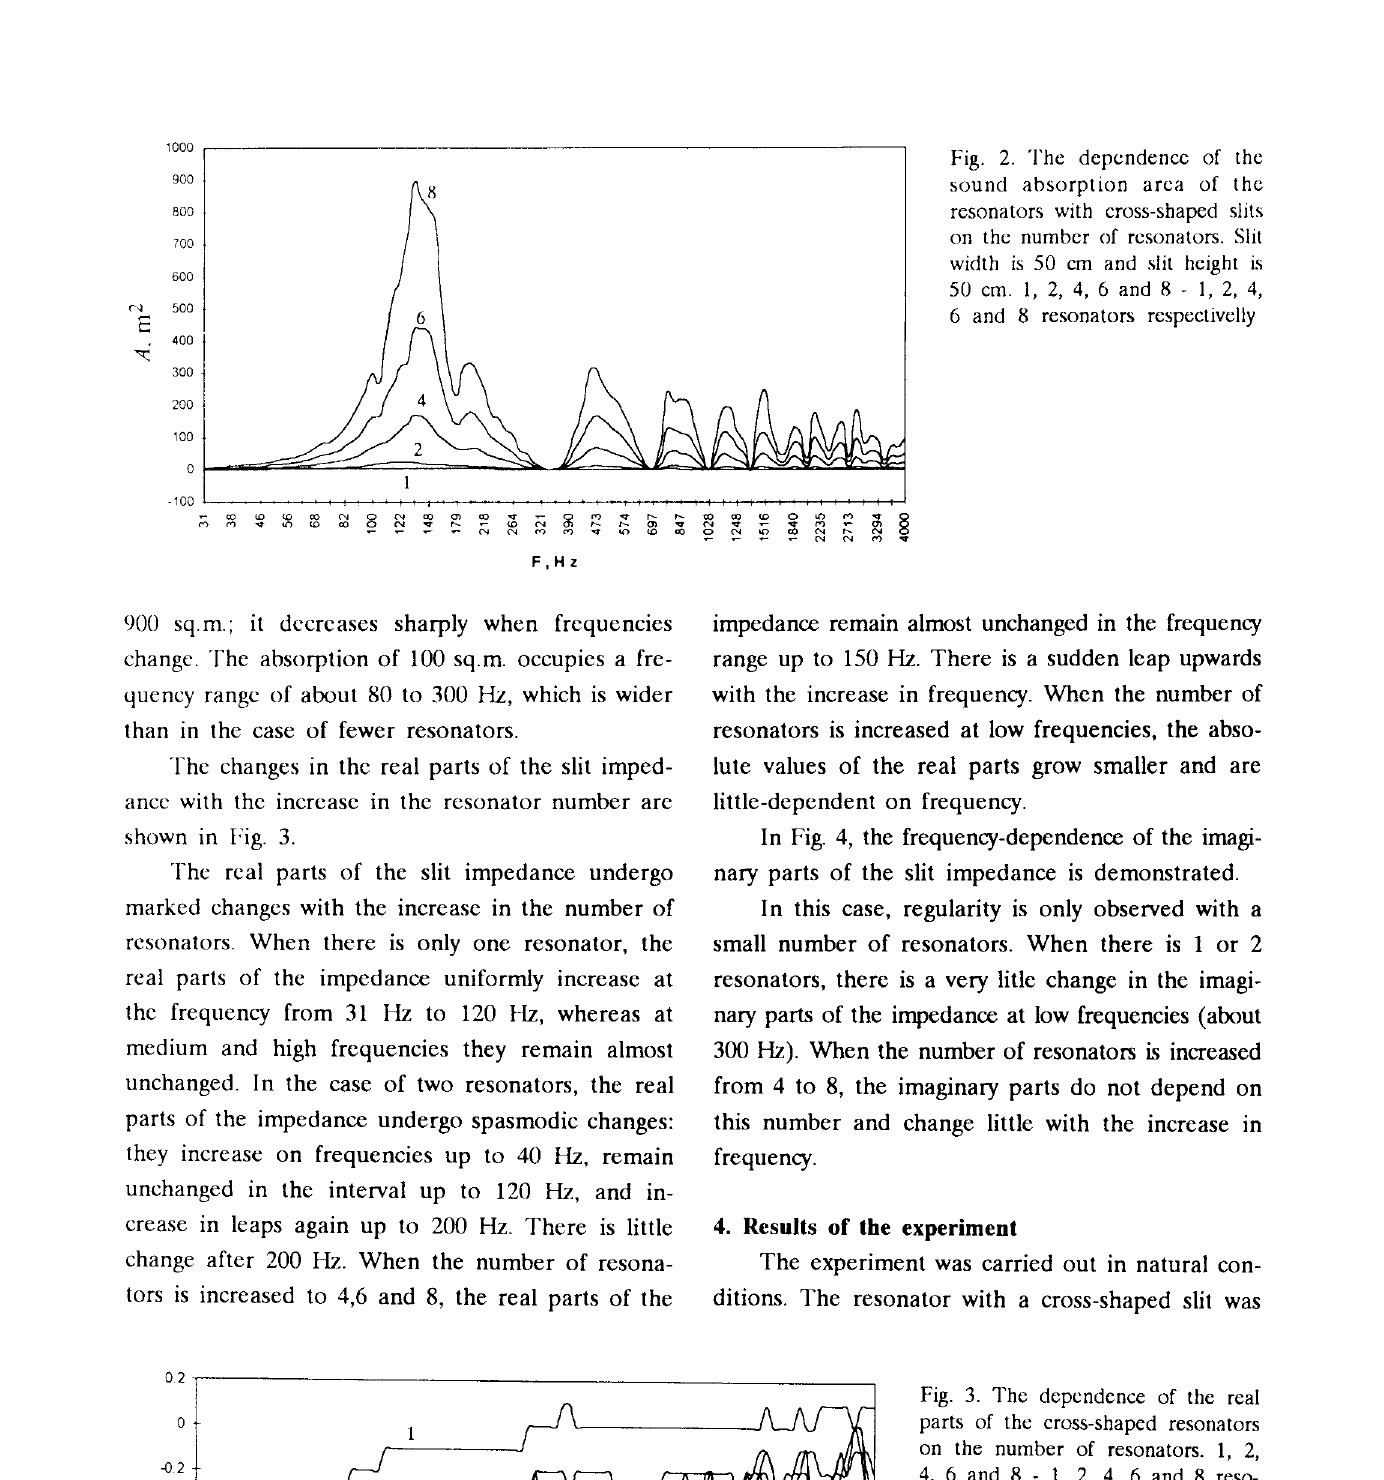
Fig. 3. The dependence of the real parts of the cross-shaped resonators on the number of resonators. 1, 2, 4, 6 and 8 - 1, 2, 4, 6 and 8 reso nators